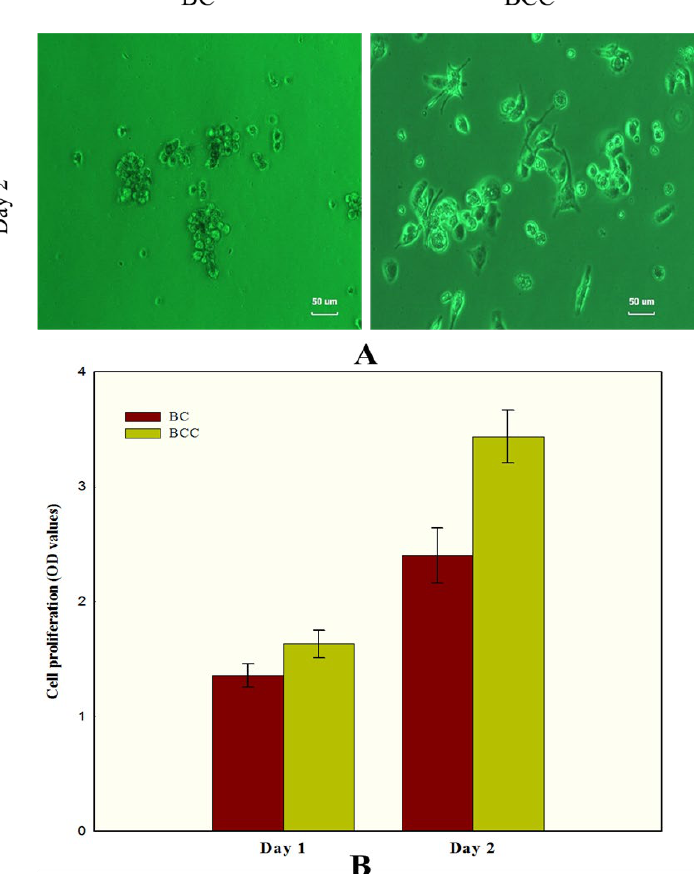
Figure 7. ( A ) Morphology observation of human keratinocytes (HaCaT) adhesion on BC and BCC composites on day 2. ( B ) Cellular proliferations on both BC and BCC at day 1 and day 2.